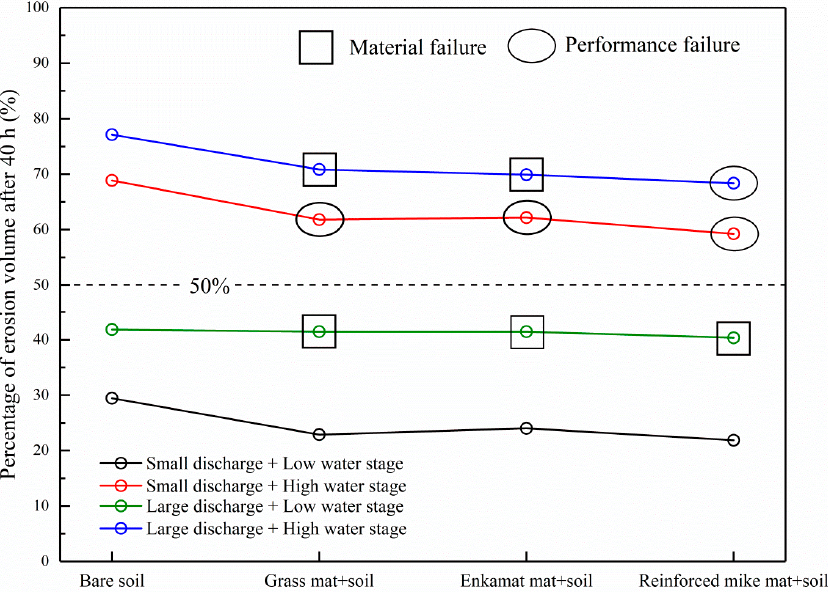
Figure 11. Volume percentage of the eroded soil after 40 h scouring for different materials.